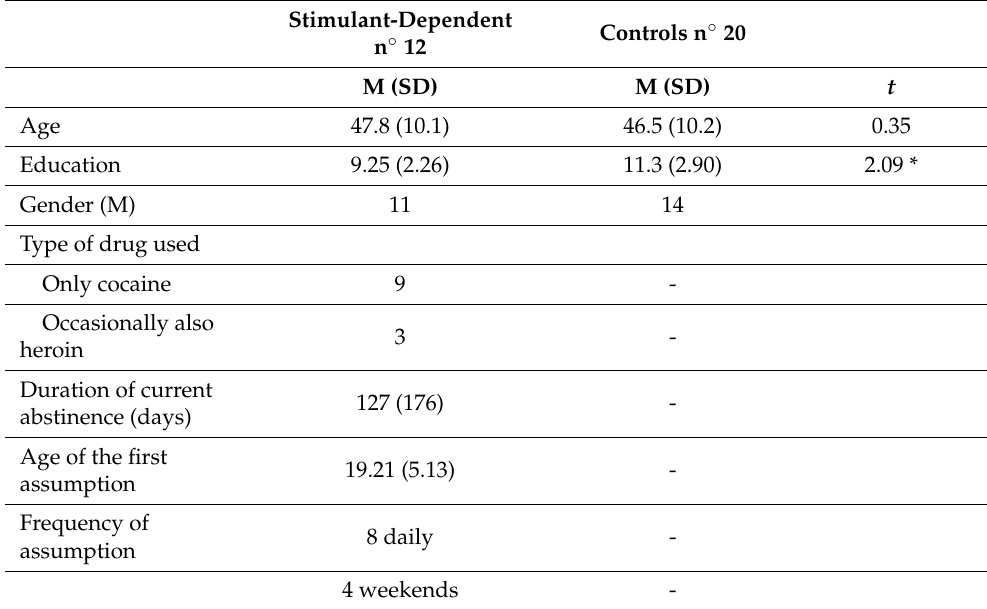
Table 1. Description (mean and standard deviation) of stimulant-dependent and control